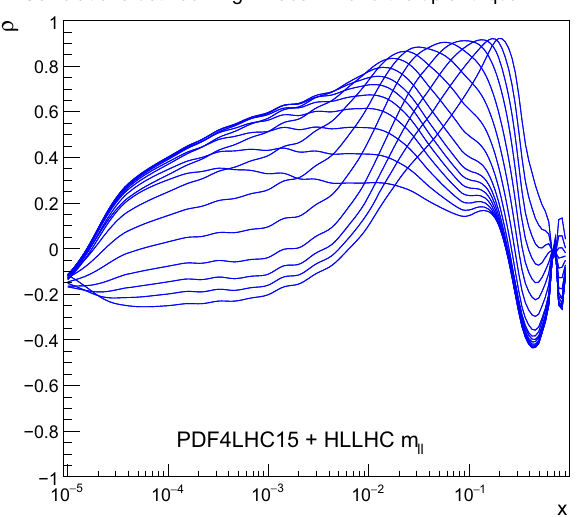
Fig. 4 The correlation coefficients ρ between the PDFs and the HL– LHC pseudo–data. Left: the correlation between the anti–up quark and the high–mass Drell–Yan pseudo–data as a function of x for Q = 100 GeV. Right: the correlation between the anti–down quark and the inclu-